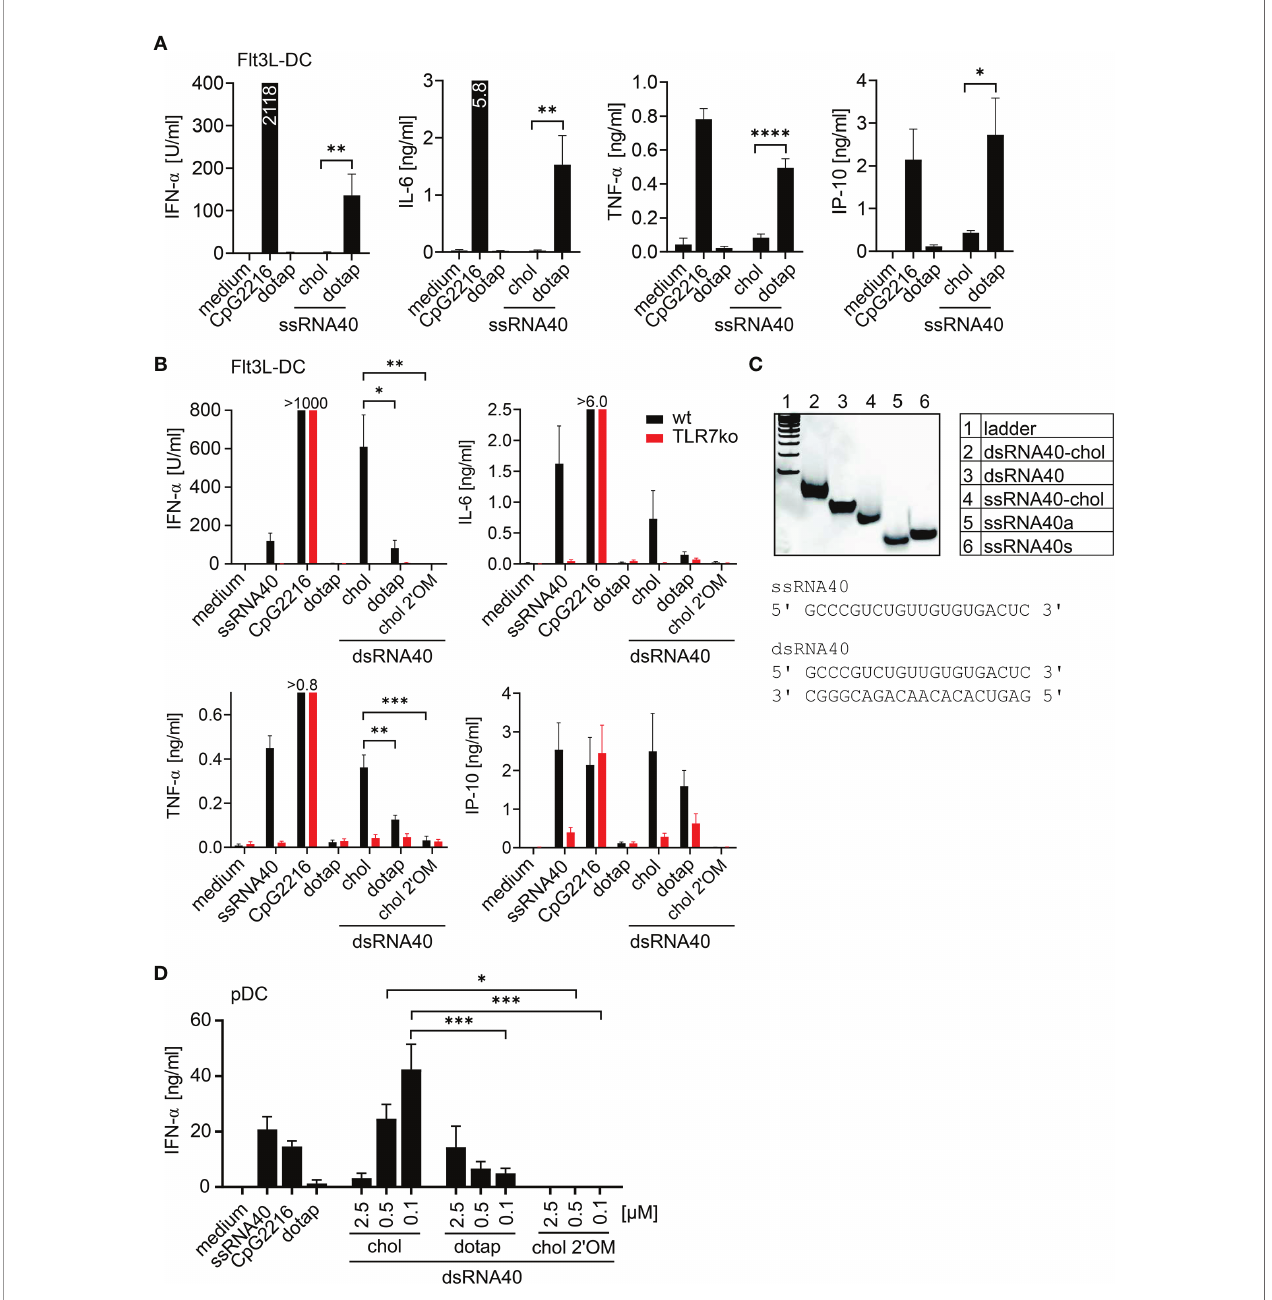
FIGURE 1 | Cholesterol-conjugated dsRNA40 induces a potent immunostimulation. (A) Wt Flt3L-DC were stimulated with 0.5 µM ssRNA40-chol or ssRNA40 complex to DOTAP. Medium, CpG2216 (1 µM) and DOTAP served as controls. Supernatants were taken after 20 h of incubation and cytokine production was analyzed by ELISA. Data were calculated from at least fi ve individual experiments. Bars indicate mean + SEM. *p < 0.05, **p < 0.01, ****p < 0.0001; unpaired t-test. (B) Wt and TLR7-de fi cient Flt3L-DC were incubated with 0.5 µM dsRNA40-chol, dsRNA40 complexed to DOTAP and dsRNA40-chol-2 ’ OM. Medium ssRNA40 (0.75 µM) complexed to DOTAP, CpG2216 (1 µM) and DOTAP served as controls. Cytokine production was analyzed by ELISA after 20 h of incubation. CpG induced > 1000 U/ml IFN- a in wt and TLR7-de fi cient cells, 6.3 ng/ml IL-6 in wt, 6.9 ng/ml IL-6 in TLR7-de fi cient cells and 0.8 ng/ml TNF- a in wt and 1.0 ng/ml TNF- a in TLR7-de fi cient cells. Data were calculated from fi ve to seven individual experiments. Bars indicate mean + SEM. *p < 0.05, **p < 0.01, ***p < 0.001; one-way ANOVA with Sidak ’ s post-hoc test. (C) Polyacrylamide gel electrophoresis of annealed dsRNA40-chol and corresponding sequences. Nucleic acids were stained with SybrGold. One representative gel out of three is shown. (D) Puri fi ed human pDC were stimulated with dsRNA40-chol, dsRNA40 complexed to DOTAP and dsRNA40-chol-2 ’ OM at 2.5 µM, 0.5 µM and 0.1 µM. Medium, ssRNA40 (0.75 µM), CpG2216 (1 µM) and DOTAP served as controls. Supernatants were harvested after 20 h of incubation and IFN- a was analyzed by ELISA. Data were calculated from three independent experiments. Bars indicate mean + SEM. *p < 0.05, ***p < 0.001; one-way ANOVA with Sidak ’ s post-hoc